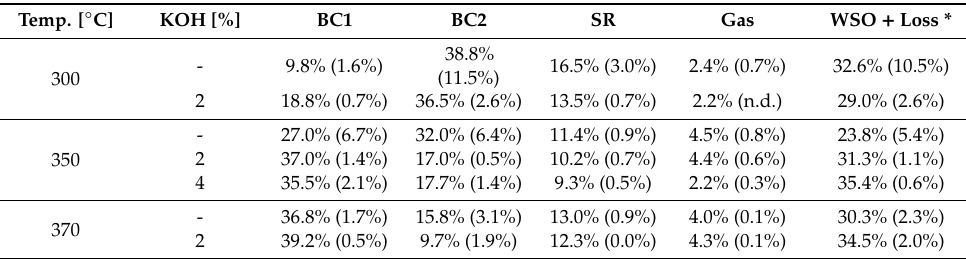
Table 3. E ff ect of base catalyzed reaction increasing KOH to LRS ratio from 2 wt. % to 4 wt. % at 300–350–370 ◦ C, 5 min and 10 wt. % B / W: mass yields of light biocrude (BC1), heavy biocrude (BC2), solid residues (SR), Gas, and water-soluble organics (WSO) + loss. Absolute standard deviation is reported in brackets.